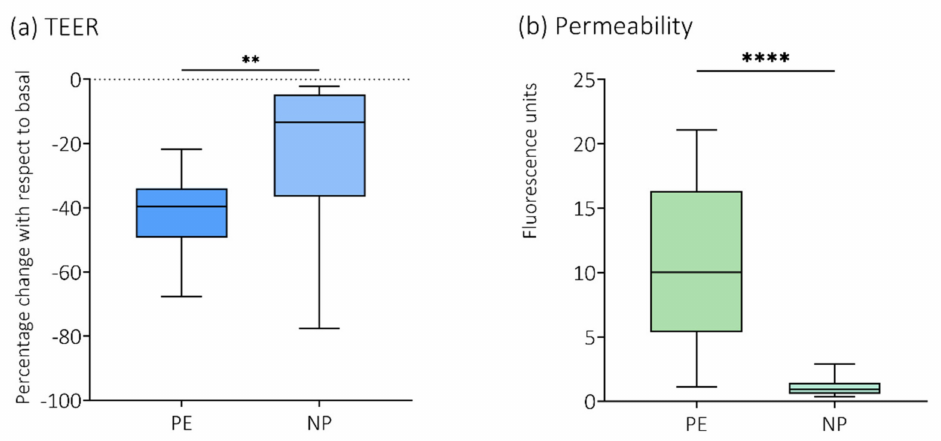
Figure 2. Re − confirmation analysis of TEER and permeability to 70 kDa Dextran. Plasma from a small, randomly chosen sample of the women with preeclampsia (PE, n = 12) and the women with normal pregnancies (NP, n = 13) was analyzed for re − confirmation of previously published data on ( a ) transendothelial electrical resistance (TEER) and ( b ) permeability to 70 kDa fluorescein isothiocyanate (FITC) − dextran [30]. ** p < 0.01; **** p <